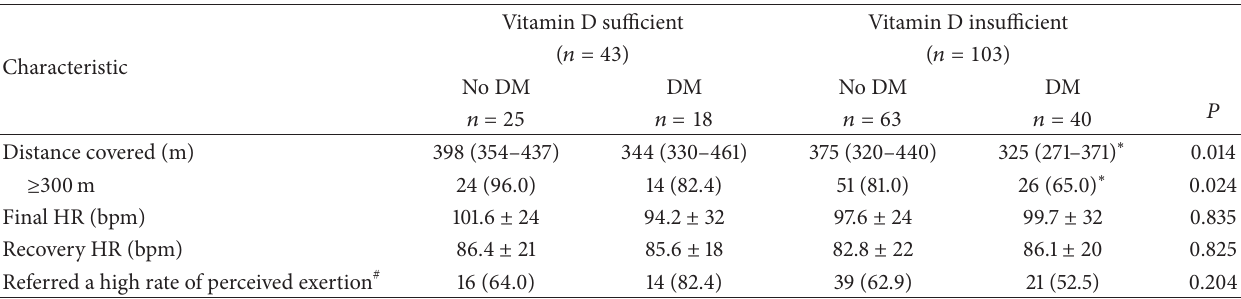
Table 3: Six minutes walking test-submaximal physical function according to vitamin D and diabetes mellitus.